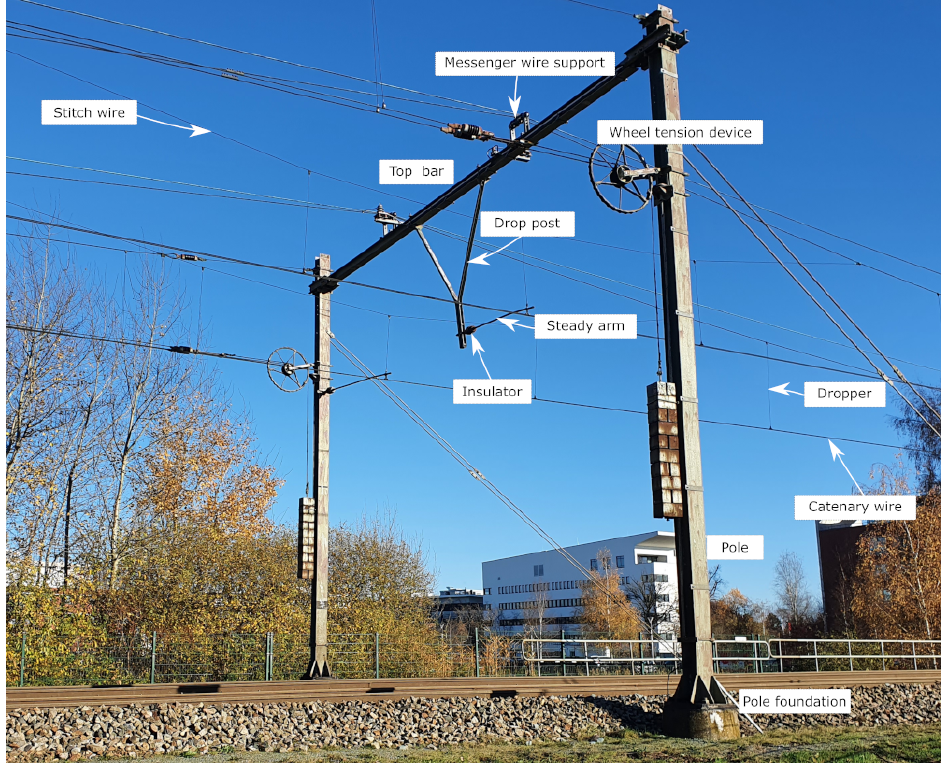
Figure 1. An example of a catenary arch (not in dataset) that shows the labels of the majority of the classes (own